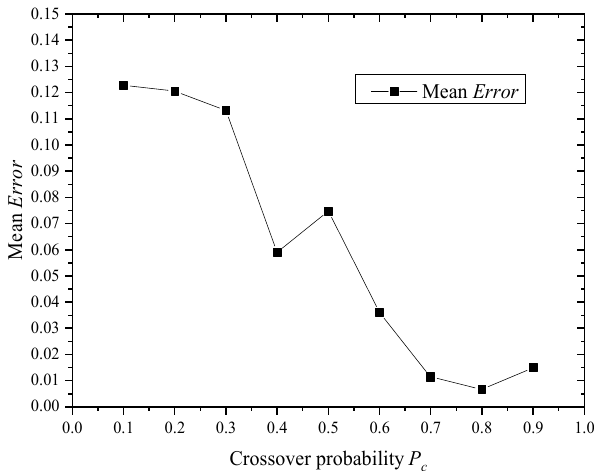
Figure 6. The mean Error values obtained by the DGA with different p c .